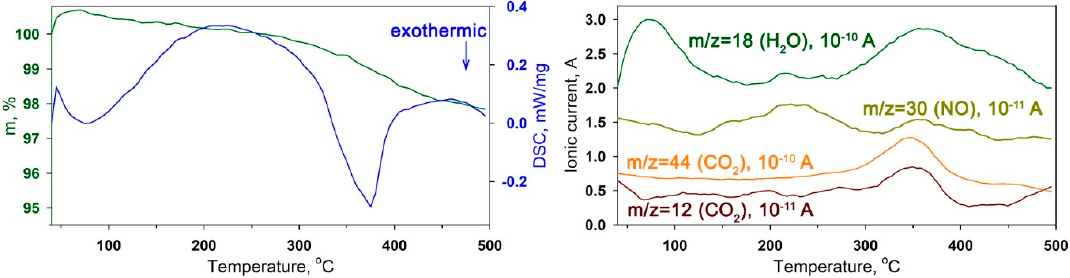
Figure 5. TG, DSC and MS curves of the SnO 2 Ru-TT hybrid sample.